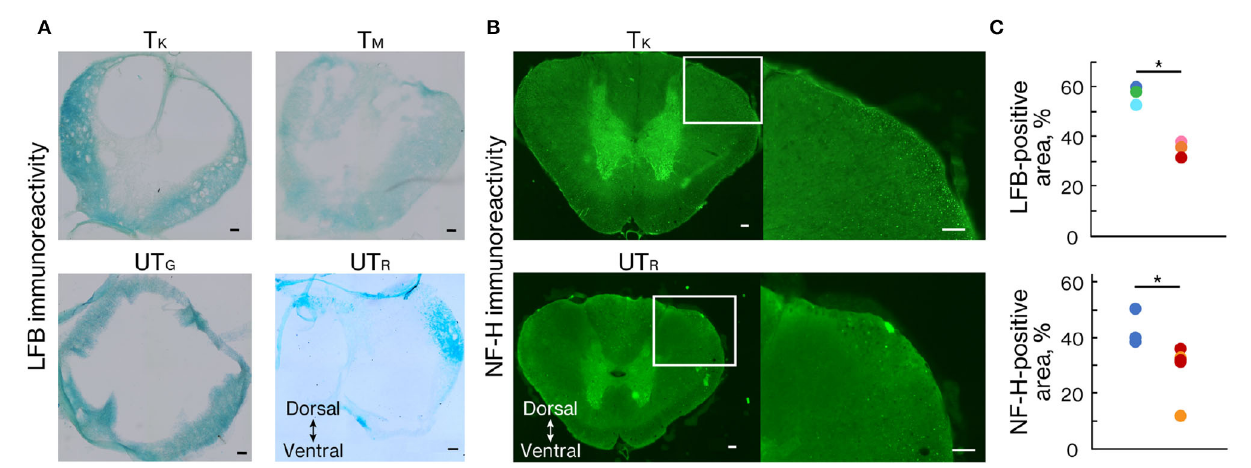
FIGURE 6 | Rehabilitation enhanced myelinated areas and fibers. (A) Luxol fast blue (LFB) and (B) NF-H staining 11 weeks after injury. (C) Percentage of the positive area in trained ( n = 3) and untrained ( n = 3) groups. The LFB-positive area was significantly more prominent at the lesion epicenter in the trained group than in the untrained group. The NF-H-positive area was significantly larger in the trained group than in the untrained group. Conventions are the same as in Figure 4D . * p < 0.05; Welch’s t -test. Scale bars = 100 µ m.